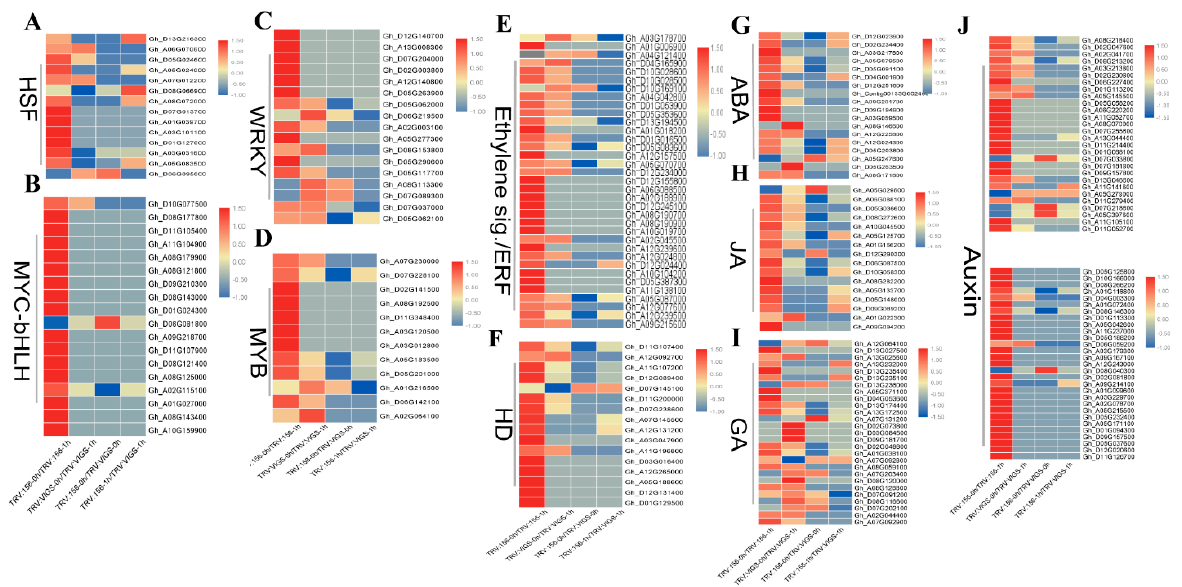
Figure 8. Heat maps indicating expression comparison of hormones or transcription-factors among four comparison sets. ( A ) Heat shock transcription factor (HSF). ( B ) MYC-bHLH. ( C ) WRKY. ( D ) MYB. ( E ) Ethylene signaling and response-factors. ( F ) Homeobox domain transcription factors (TFs). ( G ) Abscisic acid (ABA). ( H ) Jasmonic acid (JA). ( I ) Gibberellic acid (GA). ( J ) Auxin. TBtools-software was used to construct heatmaps, Red color represents upregulation, and blue color represents downregulation.